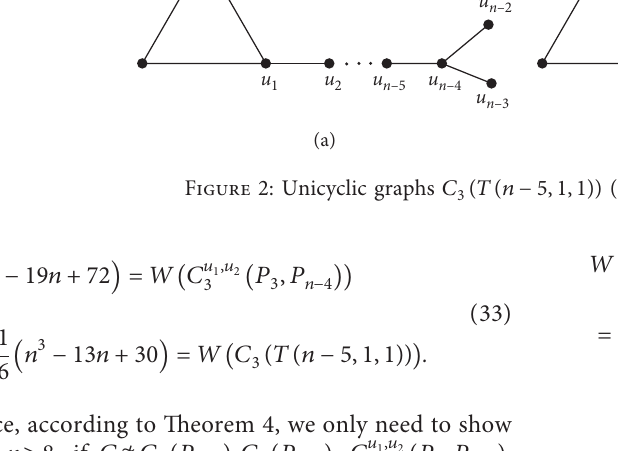
Figure 2: Unicyclic graphs C